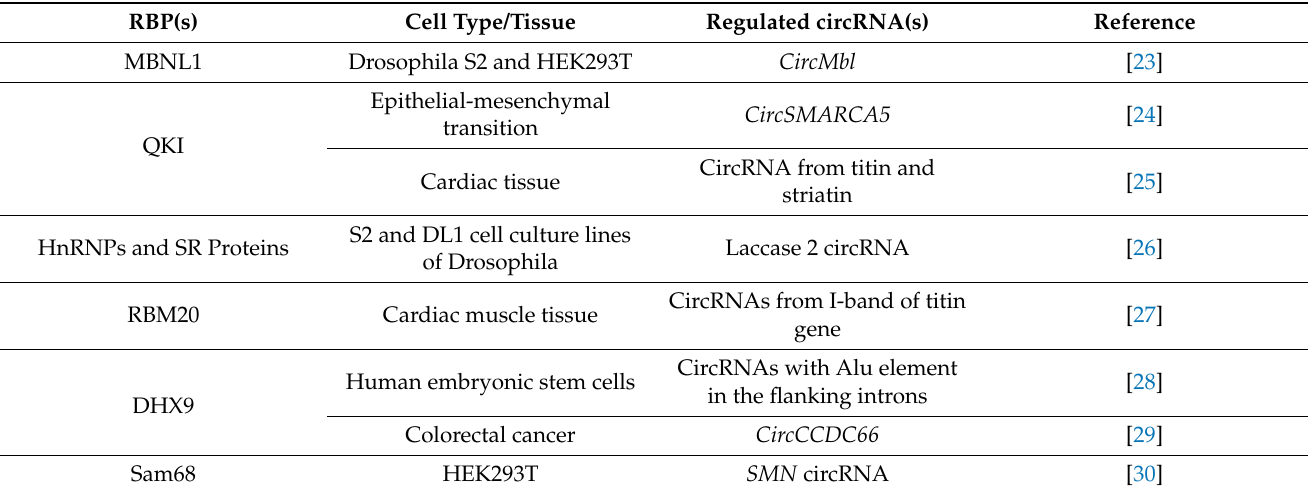
Table 1. RBPs regulating the biogenesis of